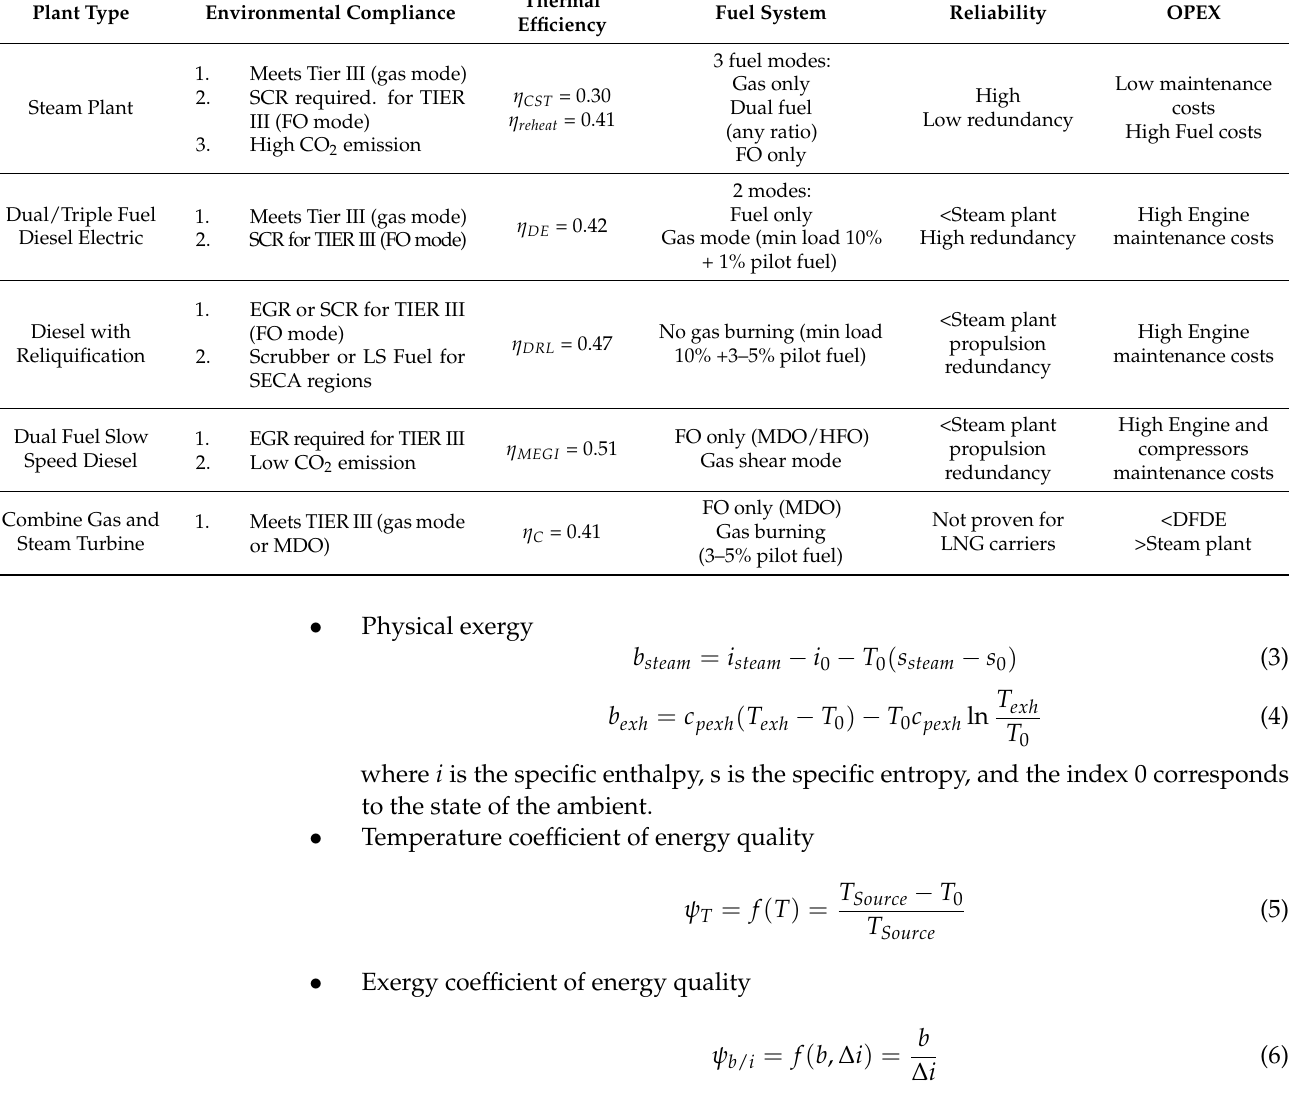
Table 1. Criterion assessment of modern LNG carrier power plants. Reproduced with permission from the MAPE Conference Organizing Team, published by New Trends in Production Engineering 2018.